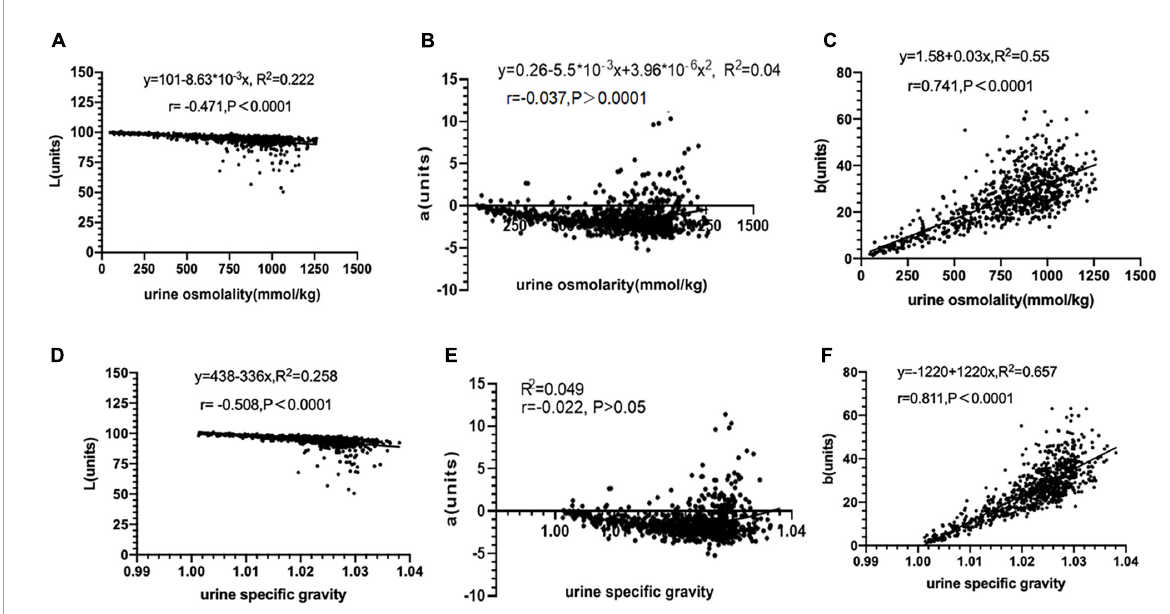
FIGURE3 Relationship between urine colour L*a*b* and urine concentration ( n = 803). (A) The relationship between urine color L* value and urine osmolality. (B) The relationship between urine color a* value and urine osmolality. (C) The relationship between urine color b* value and urine osmolality. (D) The relationship between urine color L* value and urine specific gravity. (E) The relationship between urine color a* value and urine specific gravity. (F) The relationship between urine color b* value and urine specific